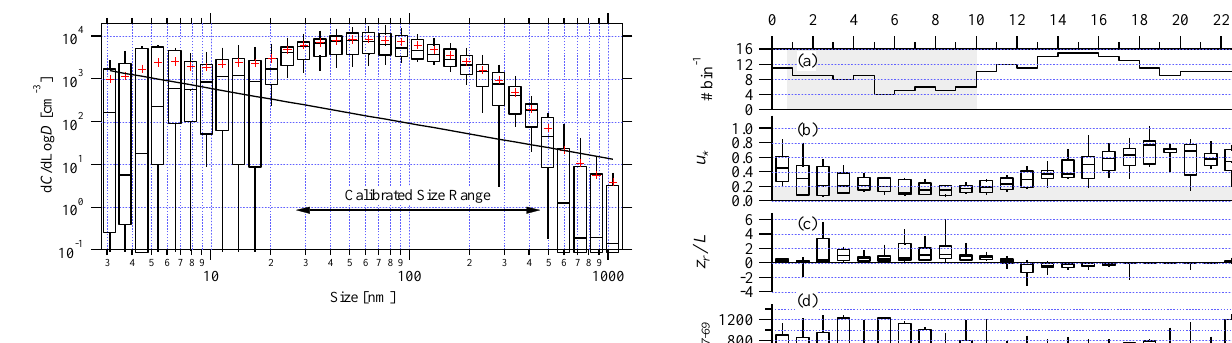
air aloft. The inset in Fig. 5f shows the temperature in the canopy ( < 23 m) increasing nearly 1.5 ◦ C between 10:00 and 10:30 UTC (lightest blue line), while the temperature above the canopy decreased approximately 1 ◦ C (black line), which would give a relative increase in NH 4 NO 3 evaporation at the canopy. However, nitrate deposition continued to increase (Fig. 5c) between 11:00 and 12:00 UTC, while temperatures were approximately equal at all